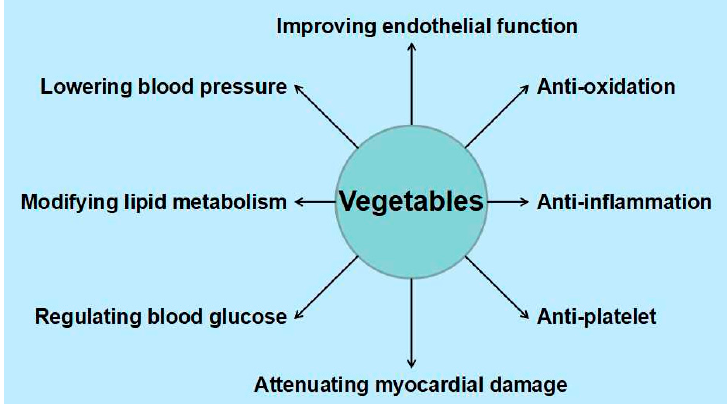
Figure 1. The cardioprotective effects of vegetables.